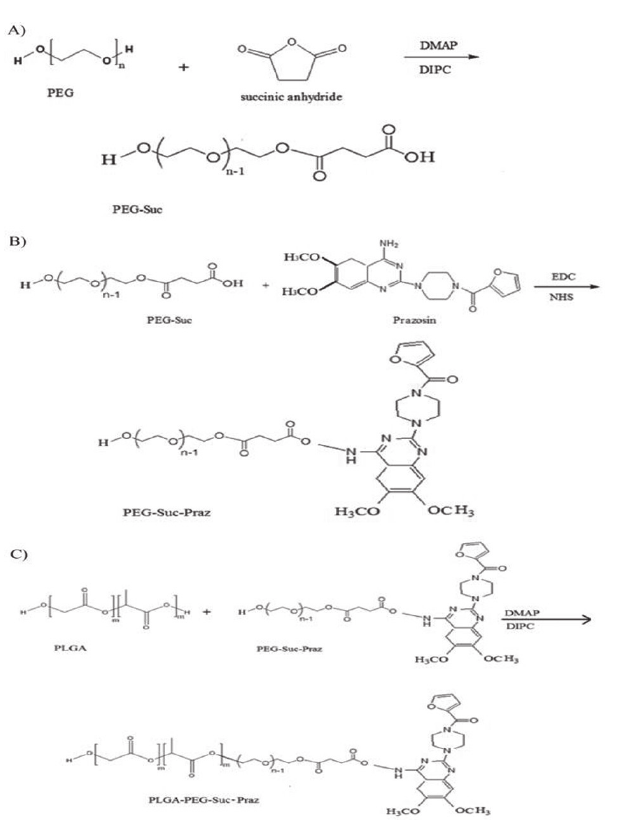
FIGURE 1 ‑ Chemical conjugation of PLGA with